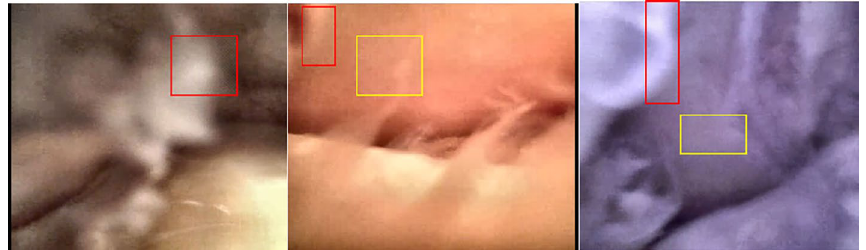
Figure 1. Frames, obtained from an muC103A camera sensor, from raw arthroscopic video sequences of three different cadaveric samples. Image quality is degraded by factors including motion blur (red rectangles) and additive noises (yellow rectangles). Due to lack of automatic white balance hardware, the acquired frames yield different color representations under halogen and white micro-LED